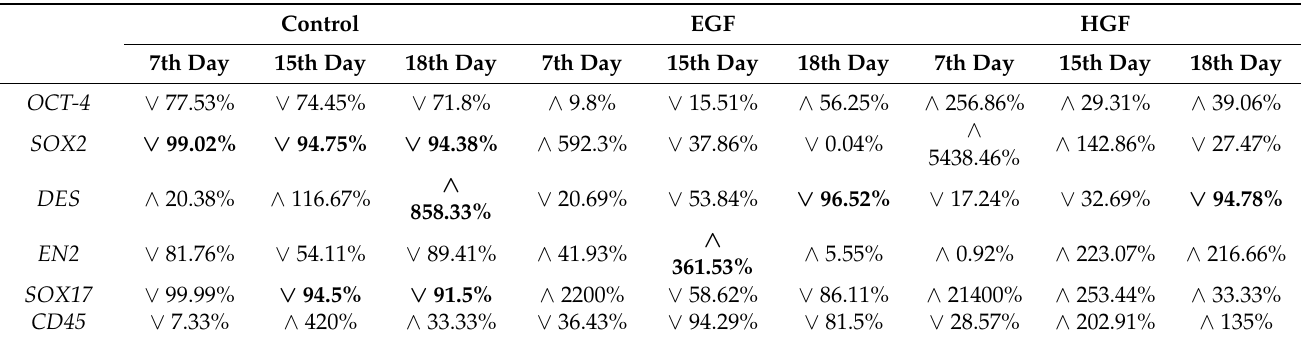
Table 5. The percentage change in the expression of marker genes of pluripotent cells ( OCT-4 , SOX2 ), mesenchymal cells ( DES ), ectodermal cells ( EN2 ), endodermal cells ( SOX17 ), and haematopoietic stem cells ( CD45 ), in the control culture (compared with 72 h) and in differentiating cultures (EGF, HGF) relative to the respective control cultures. EGF